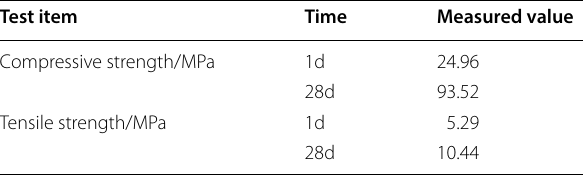
Table 4 Mechanical property of high‑performance mortar.